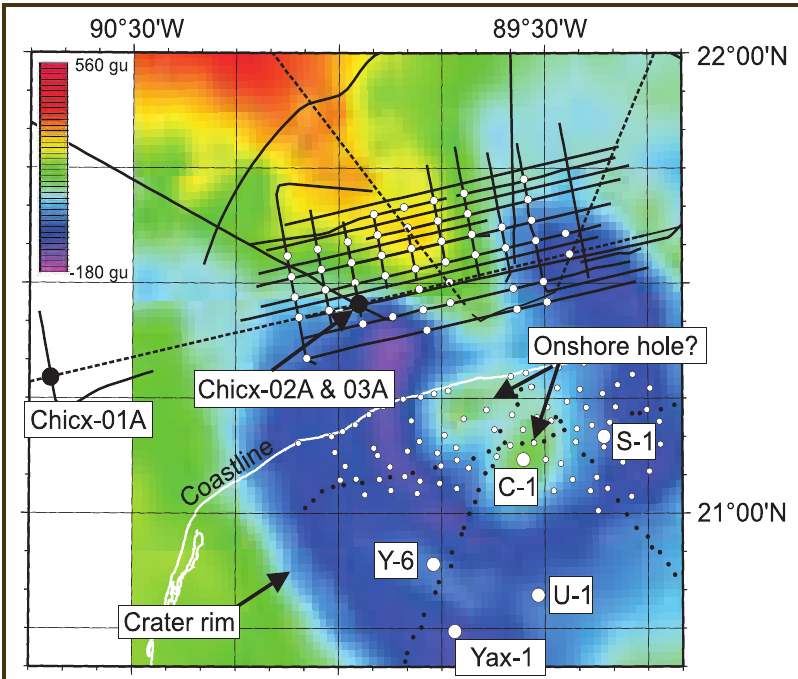
Figure 1. Solid black lines, 2005 marine seismic survey. Dashed black lines, 1996 survey. Locations of offshore and onshore seismometers are shown for the 2005 survey (small white dots) and the 1996 survey (small black dots). Large white dots mark PeMex drill holes (C-1, S-1, Y-6), UNAM hole U-1, and ICDP hole Yax-1. Black dots mark proposed offshore IODP drill sites. Background color depicts Bouguer